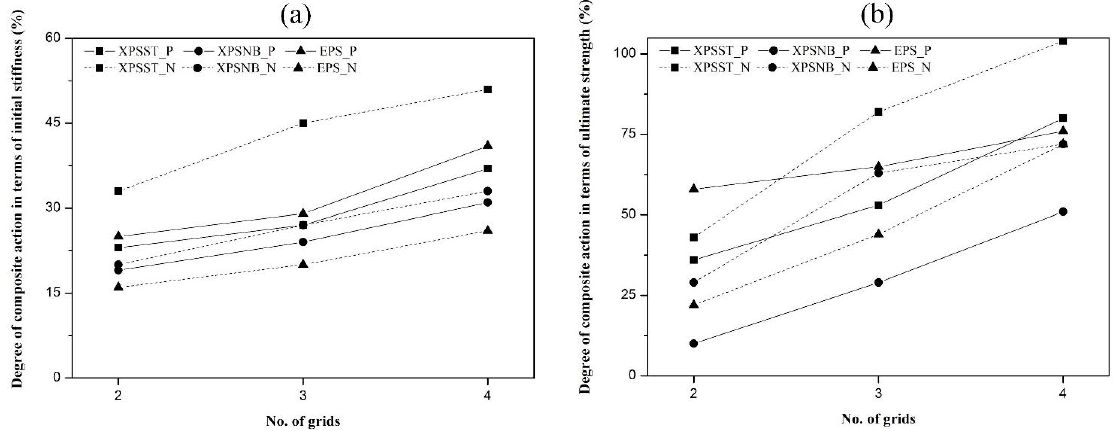
Figure 9. Degree of composite action, ( a ) initial stiffness and ( b ) ultimate